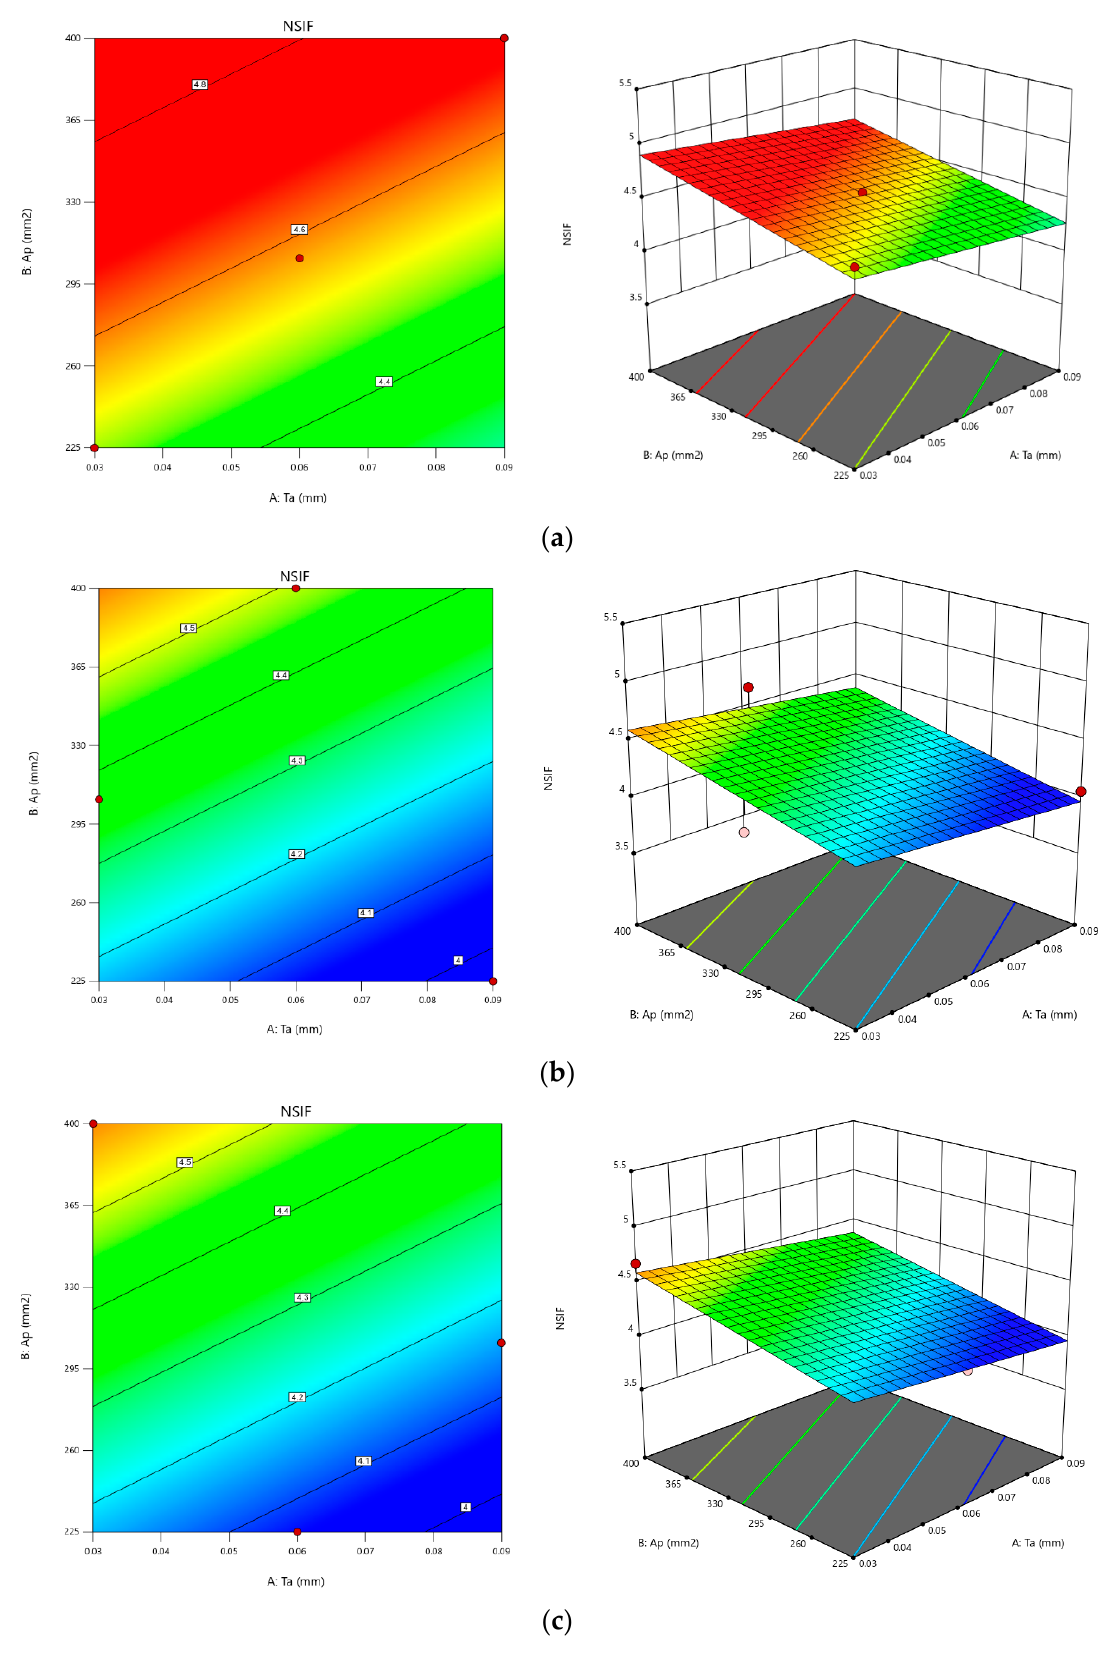
Figure 9. Contours results of NSIF. ( a ) SSP; ( b ) DSP1; ( c ) DSP2.